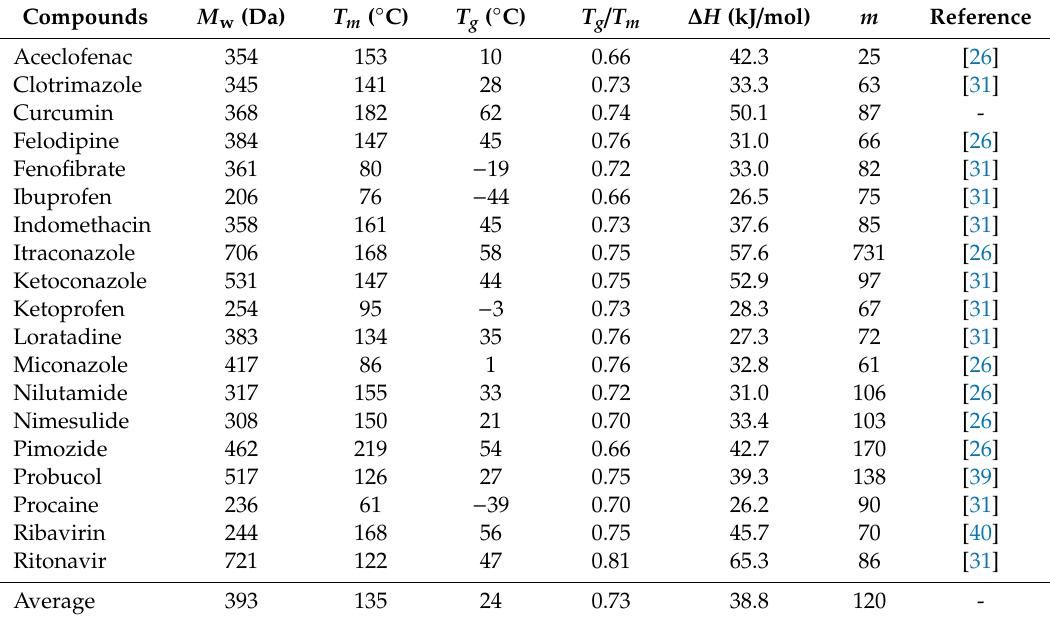
Table 4. Examples of Class 3